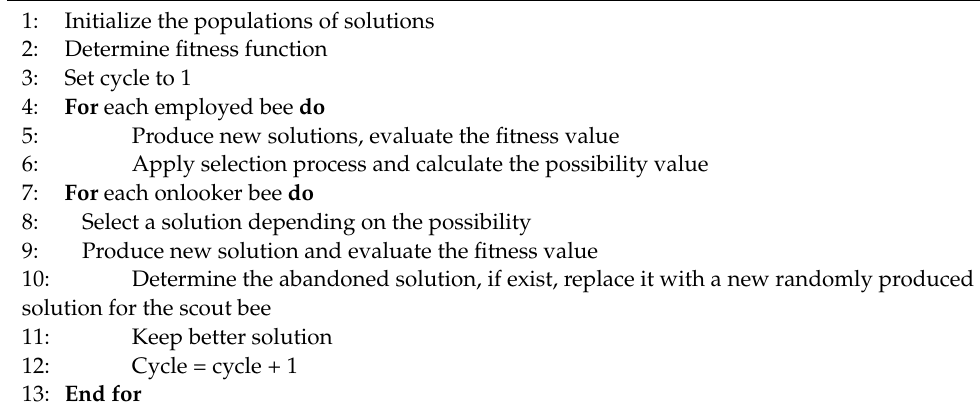
Algorithm 6. Artificial Bee Colony